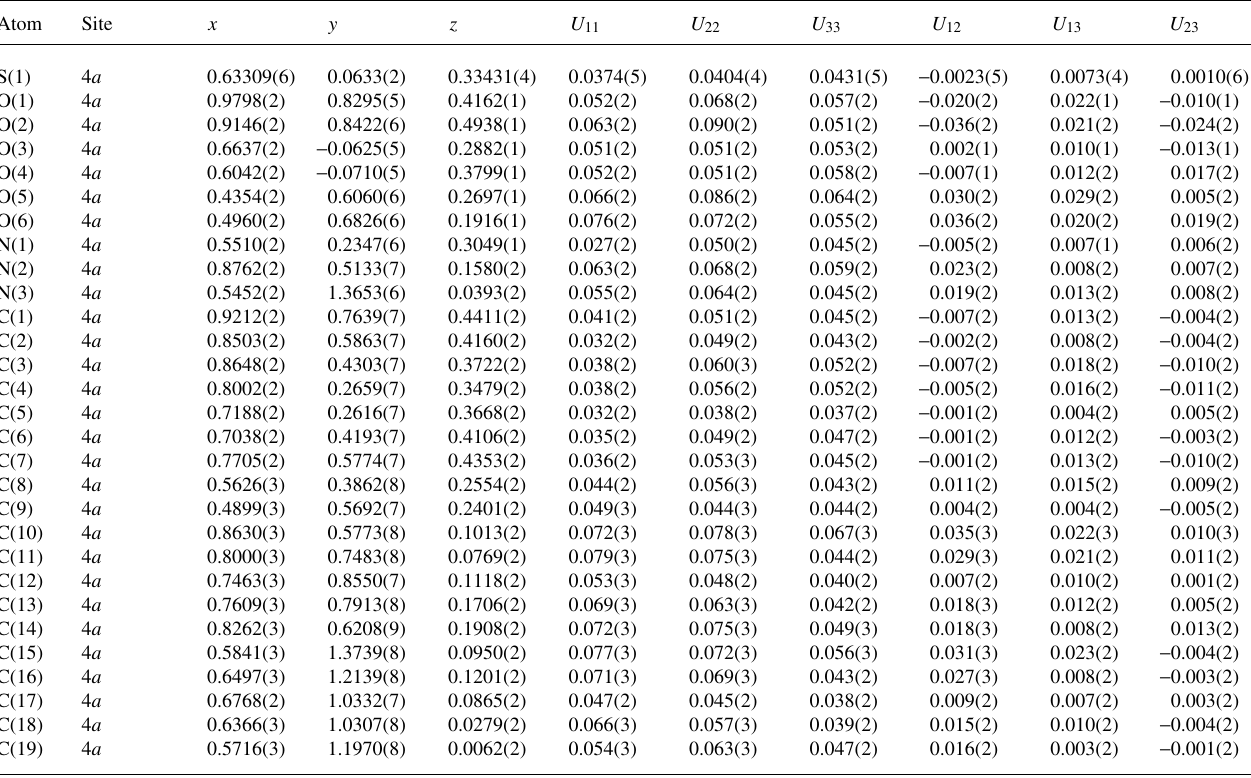
Table 3. Atomic coordinates and displacement parameters (in Å 2 )